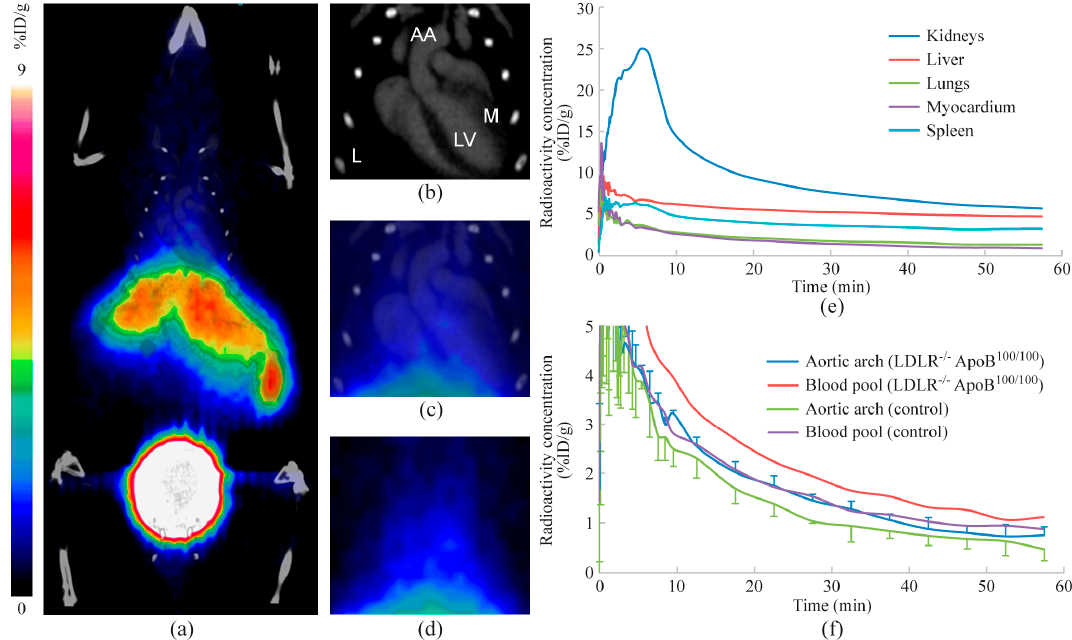
Figure 3. In vivo PET/CT imaging. Images represent radioactivity distribution at 30–60 min after injection. ( a ) A whole-body coronal PET/CT image, ( b ) contrast-enhanced CT image with anatomical landmarks ( AA , aortic arch; M , myocardium; L , lung; LV , left ventricle), ( c ) combined PET/CT and ( d ) PET show a more detailed radioactivity distribution in the thoracic region. Mean time-activity curves represent selected tissues of three atherosclerotic mice ( e) , as well as blood pool and aortic arch in both atherosclerotic (n = 3) and control mice (n = 3) ( f ).